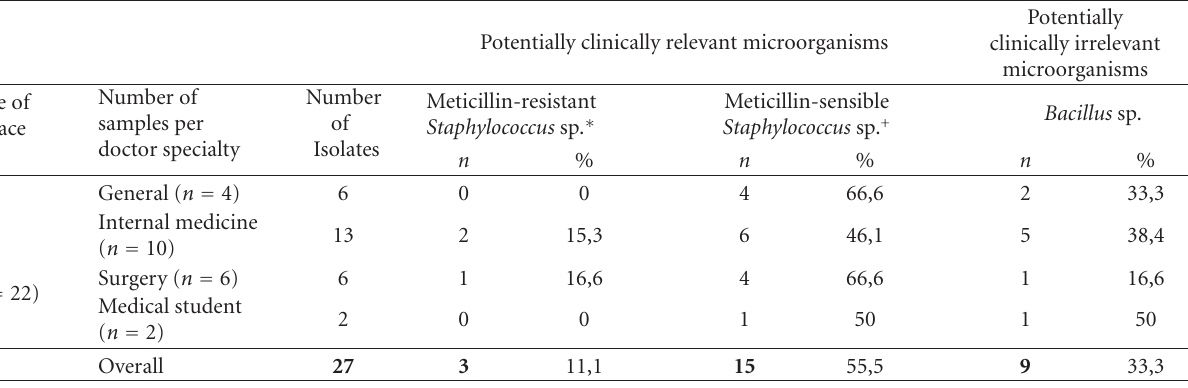
Table 5: Distribution of bacterial isolates from